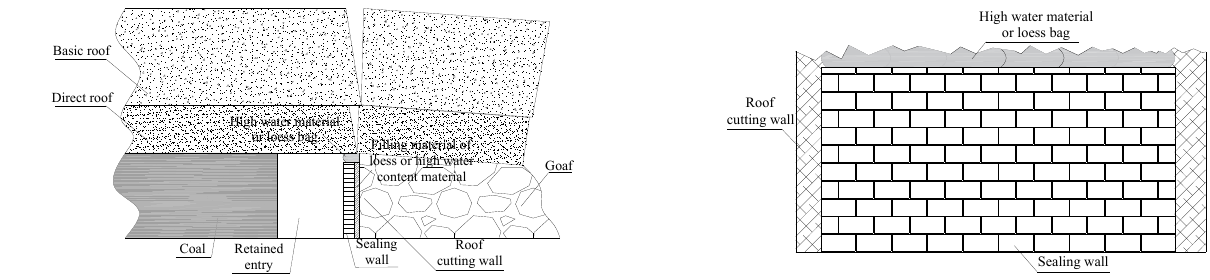
Figure 33. Schematic diagram of the masonry closure wall closure program.